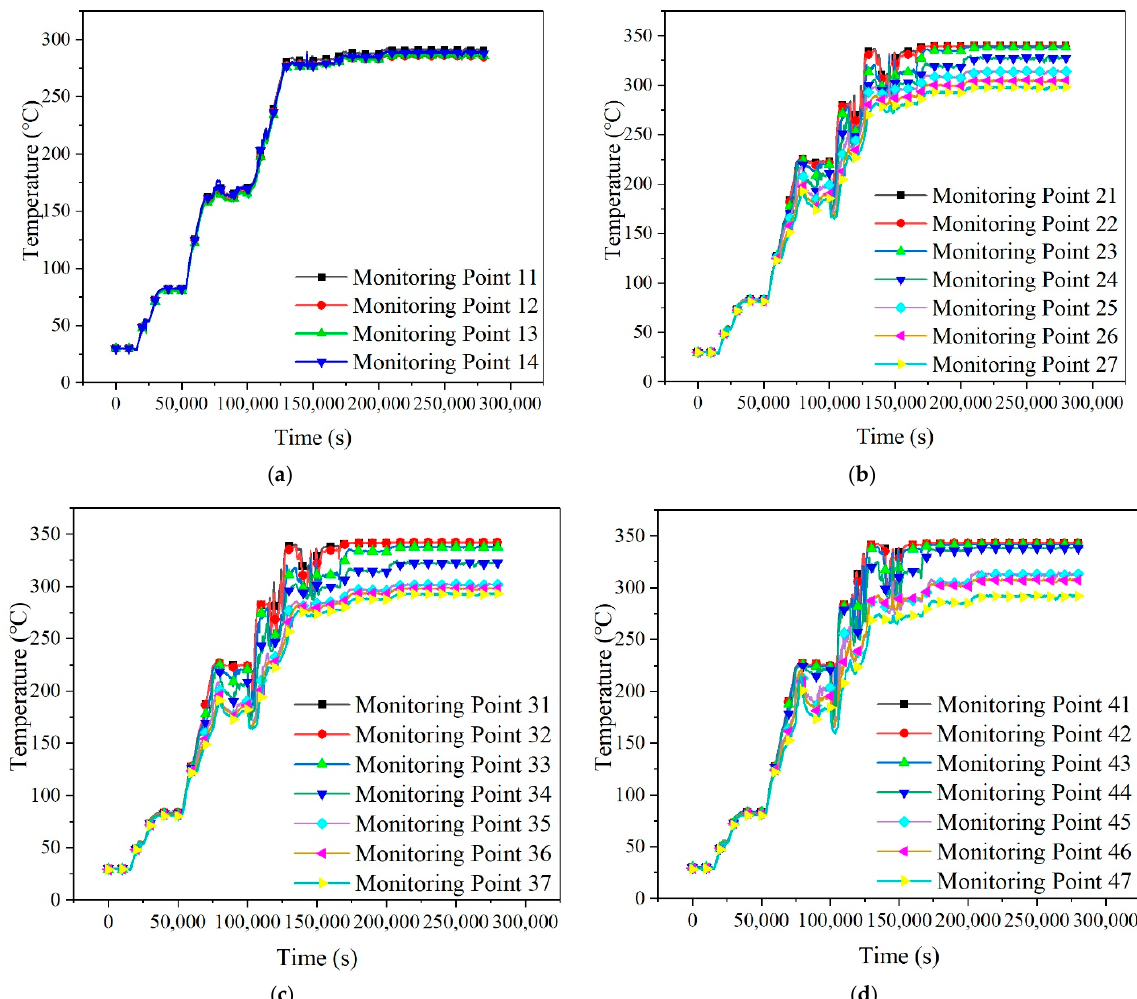
Figure 20. Temperature at each monitoring point under start-up conditions. ( a ) Monitoring Section 1. ( b ) Monitoring Section 2. ( c ) Monitoring Section 3. ( d ) Monitoring Section 4.